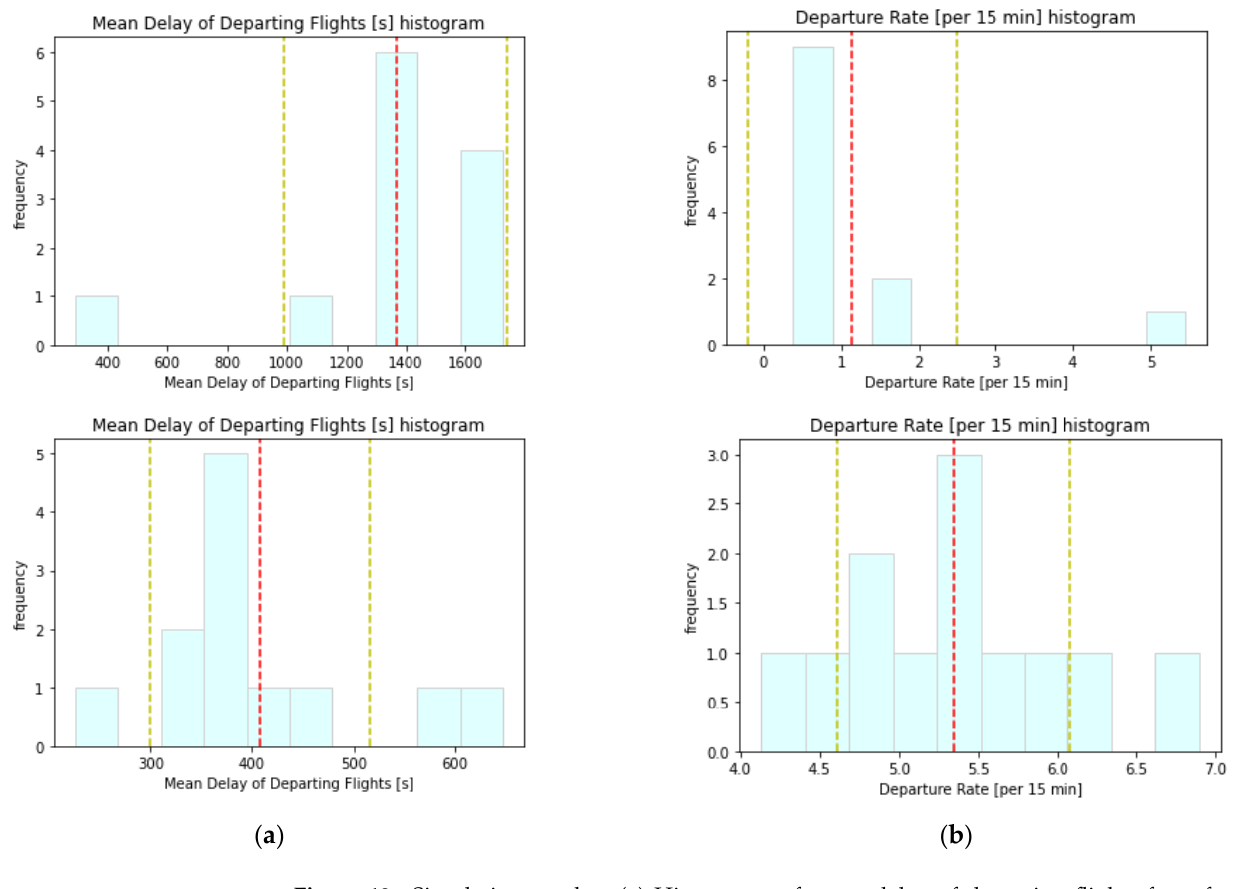
Figure 19. Simulation results. ( a ) Histograms of mean delay of departing flights for reference sce- narios ( up ) and solution scenarios ( down ). ( b ) Histograms of departure rate (per 15 min) for reference scenarios ( up ) and solution scenarios ( down ). Red vertical lines represent the mean values, whereas yellow vertical lines represent the intervals for the standard deviation.